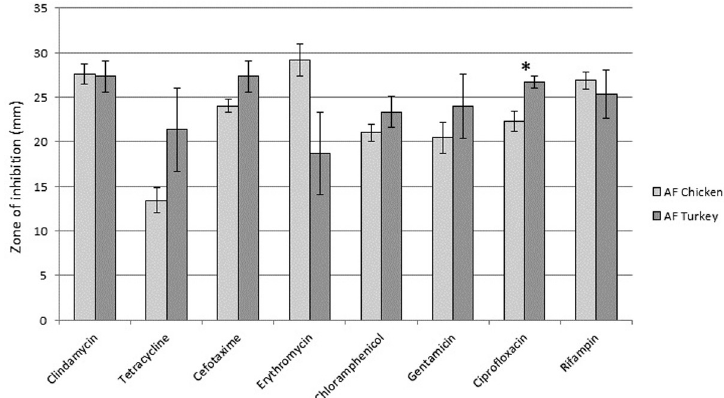
Fig 2. Mean antibiotic resistance in AF raw poultry SA isolates for eight common antibiotics. Disk diffusion tests were performed to determine the amount of antibiotic required to prevent growth of the various SA raw meat isolates. A two sample t-test with unequal variance test was used to determine if there were significant differences in rates of antibiotic resistance or susceptibility amongst the various meat types. � indicates p �